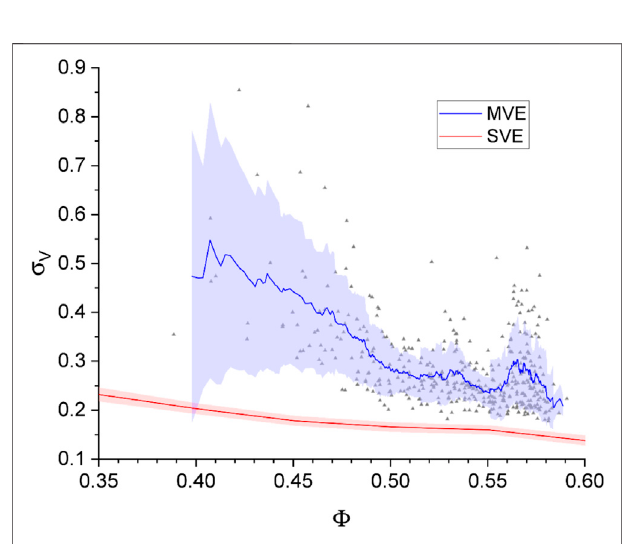
FIGURE 8 | Standard deviation of Voronoi-polygon areas σ V of MVEs and SVEs. Grey dots show the individual MVE cases. The highlighted areas show the standard deviation of the moving average of 30 cases for the MVEs and the standard deviation of the 10 SVEs per fi ber volume fraction generated.